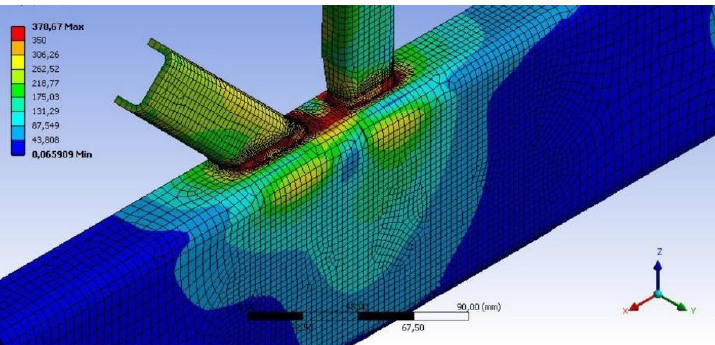
Figure 16. Failure in joint NP10 with V-notched hole and braces angles of 45–90°.